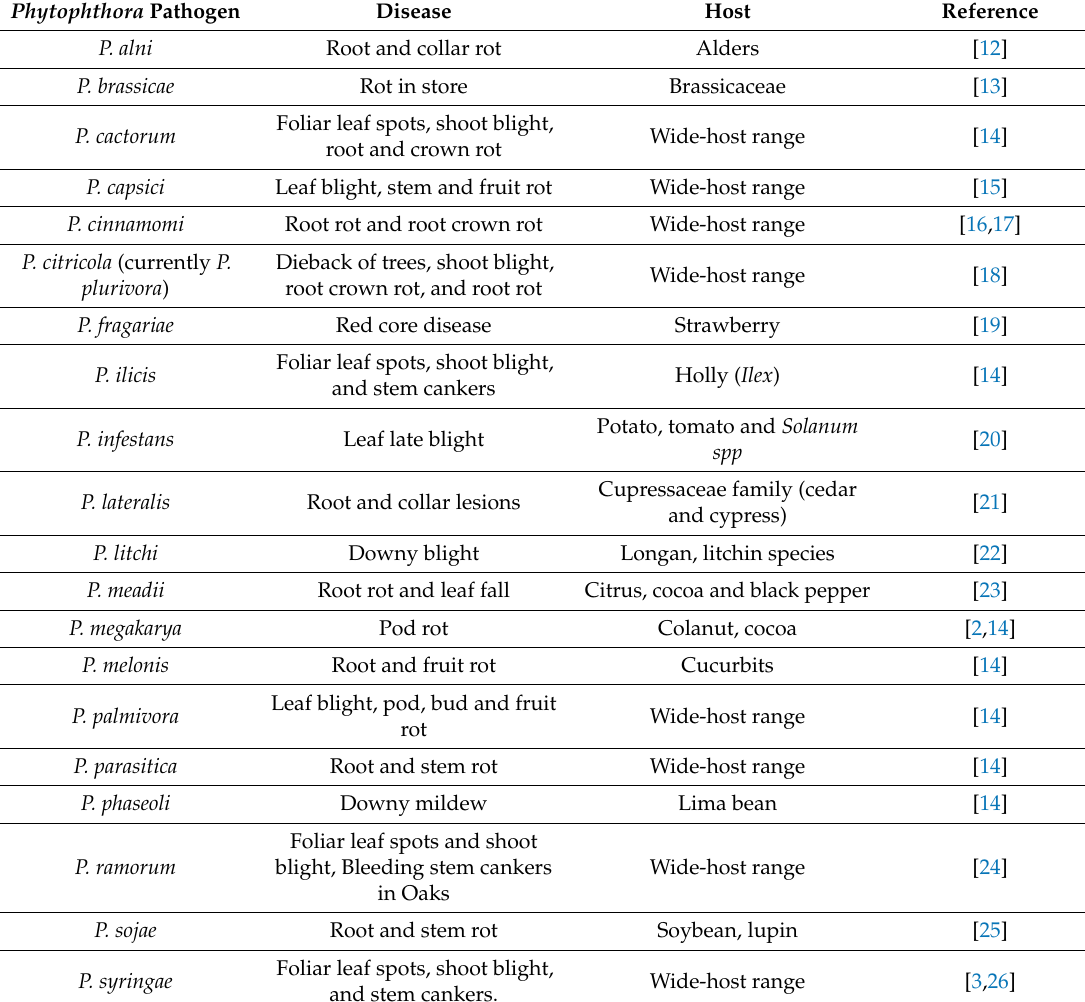
Table 2. Phytophthora pathogens with their respective diseases and